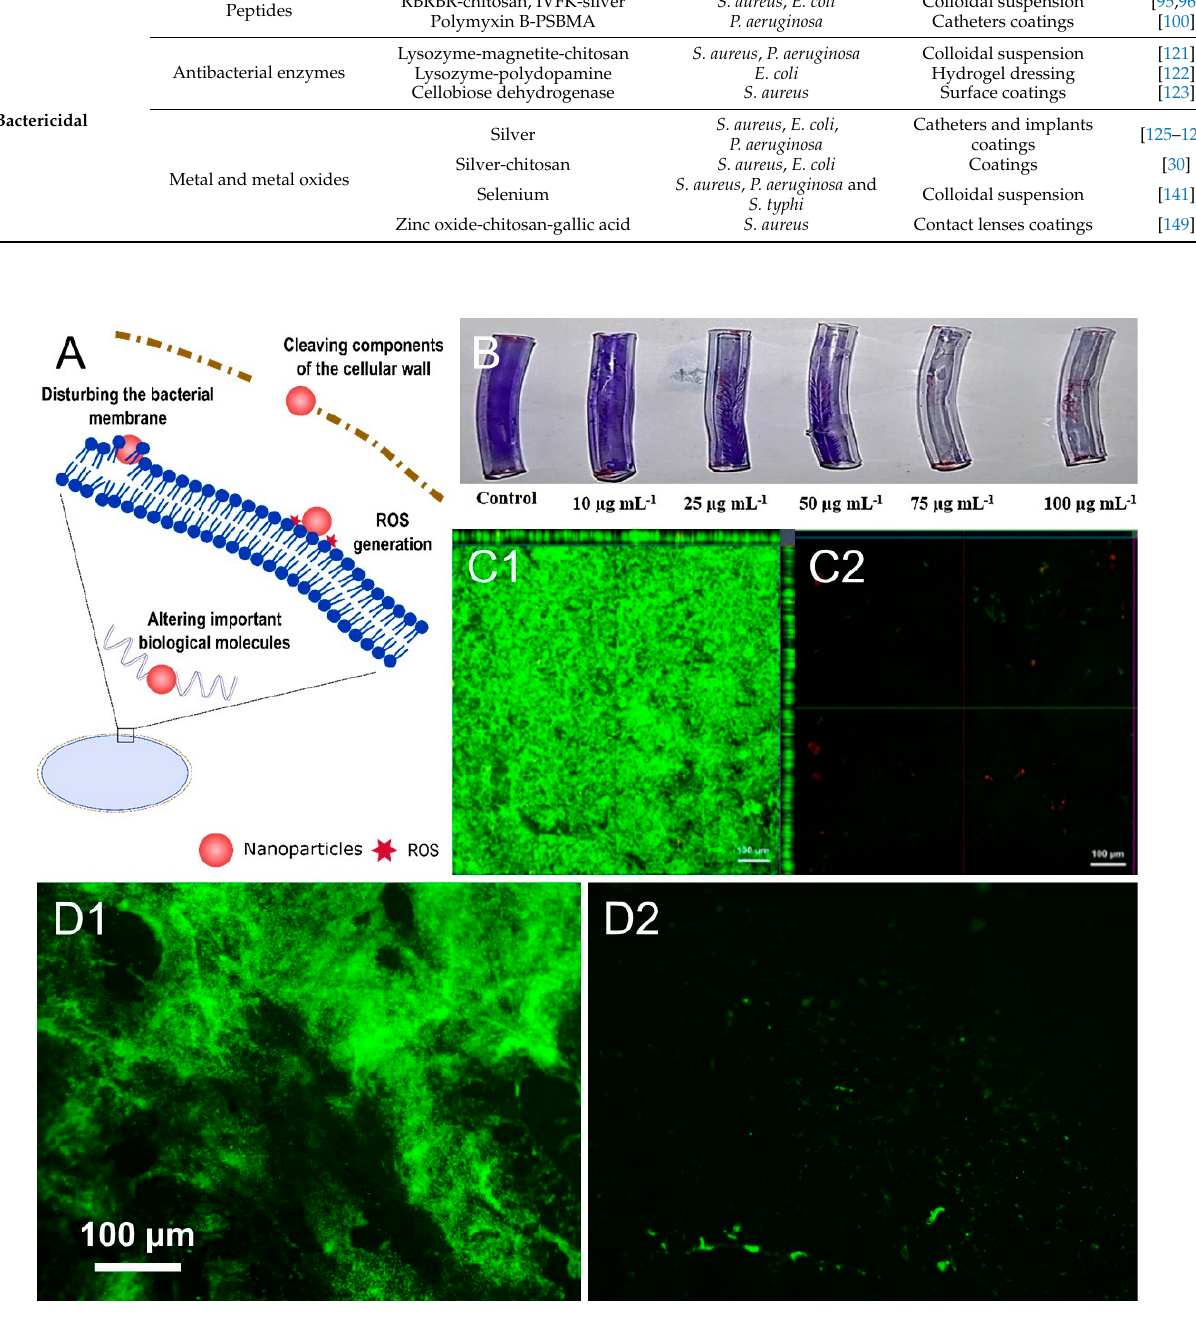
Figure 3. ( A ) Schematic representation of the antimicrobial mechanisms of action of bactericidal NPs covered in this review. ( B ) Cristal violet staining of P. aeruginosa biofilm grown on catheters coated with different concentrations of AgNPs (Reprinted from Prog. Org. Coati, 151, LewisOscar et al., ‘In vitro analysis of green fabricated silver nanoparticles (AgNPs) against Pseudomonas aeruginosa PA14 biofilm formation, their application on urinary catheter,’ 106058, Copyright 2021, with permission from Elsevier [126]). ( C ) Confocal microscopy images of untreated biofilm ( C1 ) and treated with chitosan-cellobiose dehydrogenase-DNase NPs ( C2 ) (Reprinted from Mater. Sci. Eng. C, 108, Tan et al., ‘Co-Immobilization of Cellobiose Dehydrogenase and Deoxyribonuclease I on Chitosan Nano- particles against Fungal/Bacterial Polymicrobial Biofilms Targeting Both Biofilm Matrix and Micro- organisms,’ 110499, Copyright 2019, with permission from Elsevier [124]). ( D ) Fluorescence micros- copy images showing the grown of P. aeruginosa biofilm on pristine silicone catheters ( D1 ) and its inhibition when the catheters were coated with self-assembled pSBMA-polymyixin B NPs ( D2 ) (re- produced from [100] under the terms of the Creative Commons Attribution International License (CC BY 4.0)).